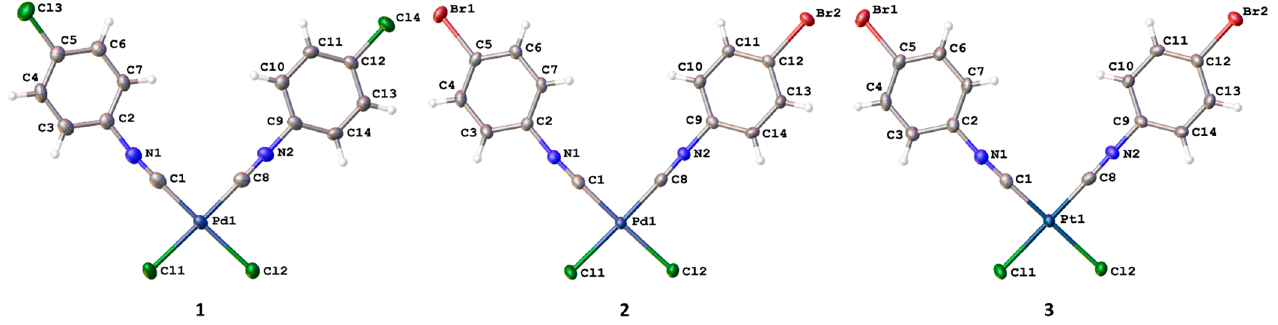
Figure 1. View of complexes 1 – 3 with the atomic numbering scheme. Thermal ellipsoids are drawn with the 50% probability. Hydrogen labels are omitted for simplicity.